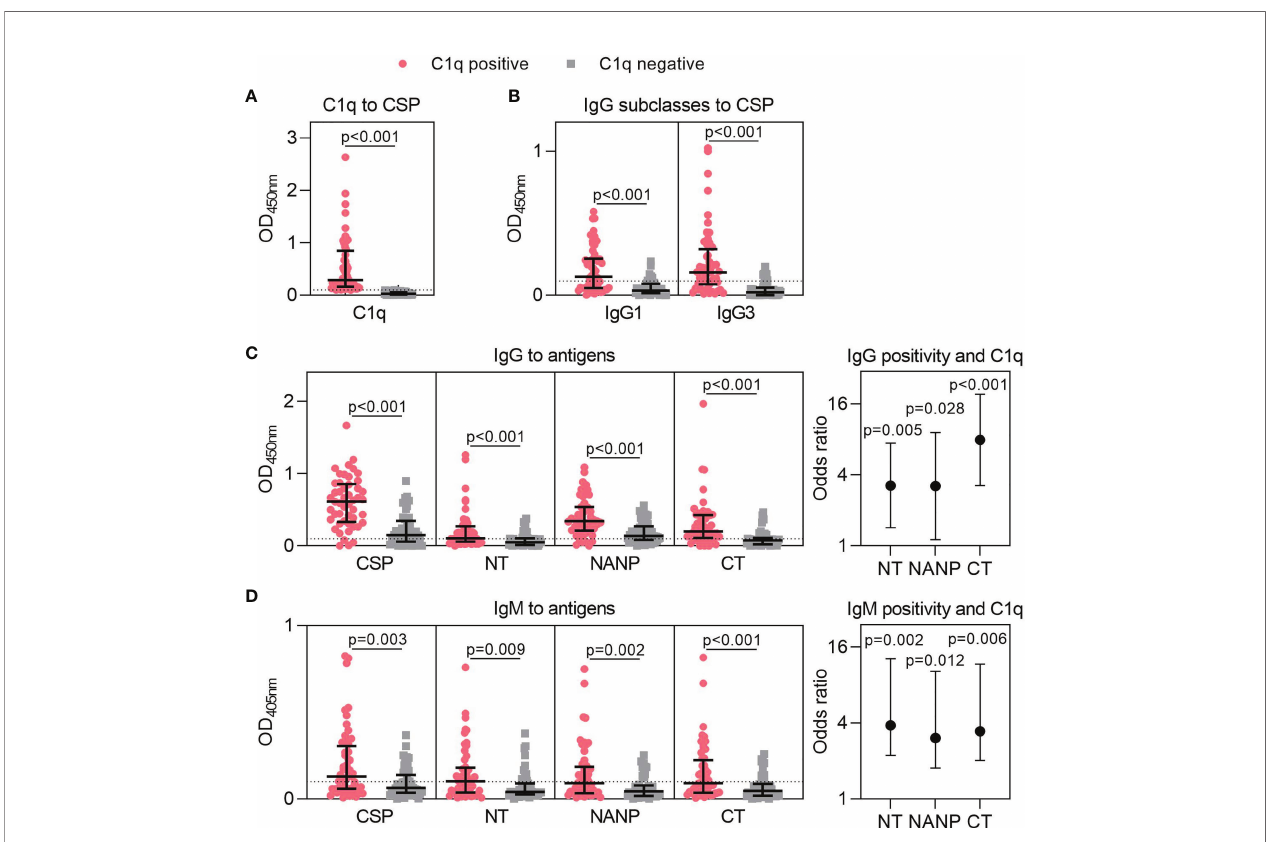
FIGURE 2 | Targets of naturally acquired antibodies associated with complement- fi xation to CSP. Plasma collected from malaria-exposed adults (n=102) were tested for (A) C1q- fi xation to CSP and strati fi ed into positive and negative groups (C1q positive, n=52; C1q negative, n=50). The C1q positive and C1q negative groups were tested for (B) IgG1 and IgG3 subclasses to CSP, and (C) IgG and (D) IgM to full-length CSP and antigens representing the N-terminal (NT), central- repeat (NANP) and C-terminal (CT) regions of CSP. Samples were tested in duplicate, and the mean of duplicates is shown along with the group median and IQR. Dotted lines represent the positivity threshold relative to malaria-naïve negative controls. Reactivity between C1q positive and C1q negative groups were compared using the Mann-Whitney U test. In panels (C, D) , the odds ratio and 95% con fi dence interval are shown for IgG/IgM positivity to each region of CSP and C1q- fi xation positivity using logistic regression; y-axis was presented on a log2